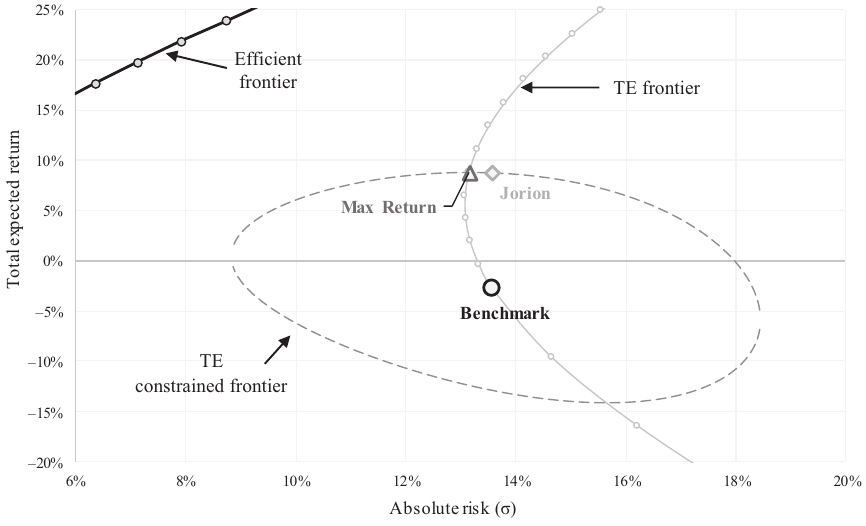
Figure 12. Test 1, high